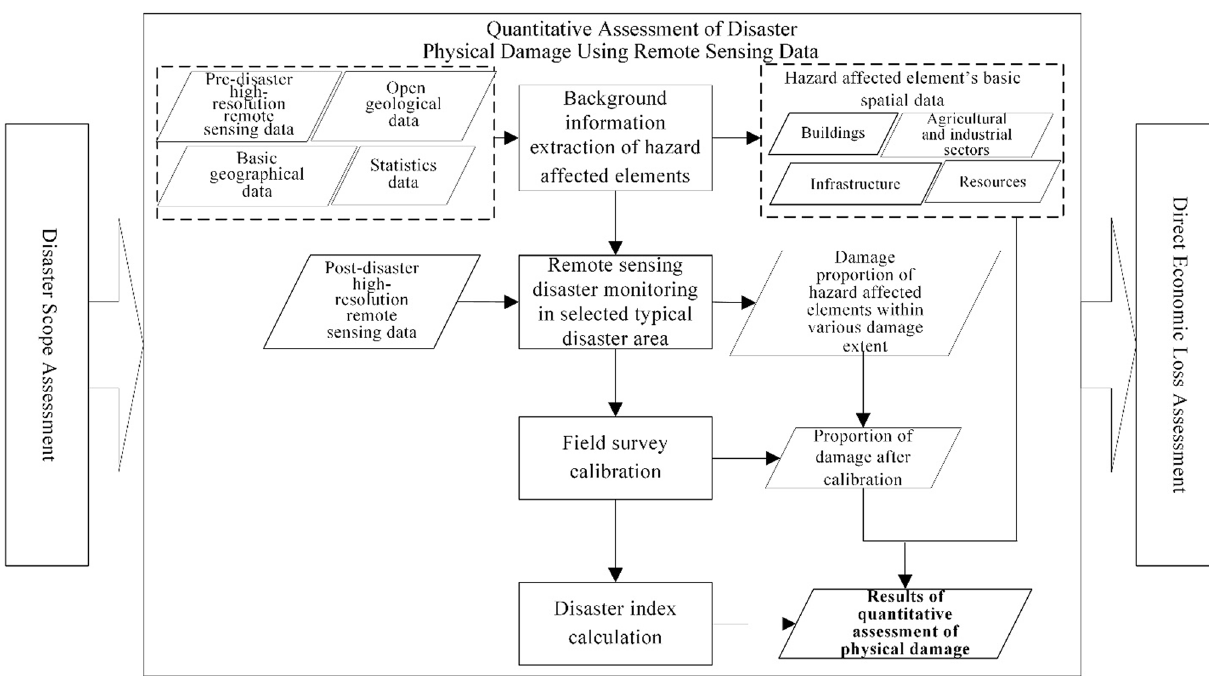
Fig. 1 Schematic diagram of the quantitative assessment of disaster physical damage using remote sensing data method developed in